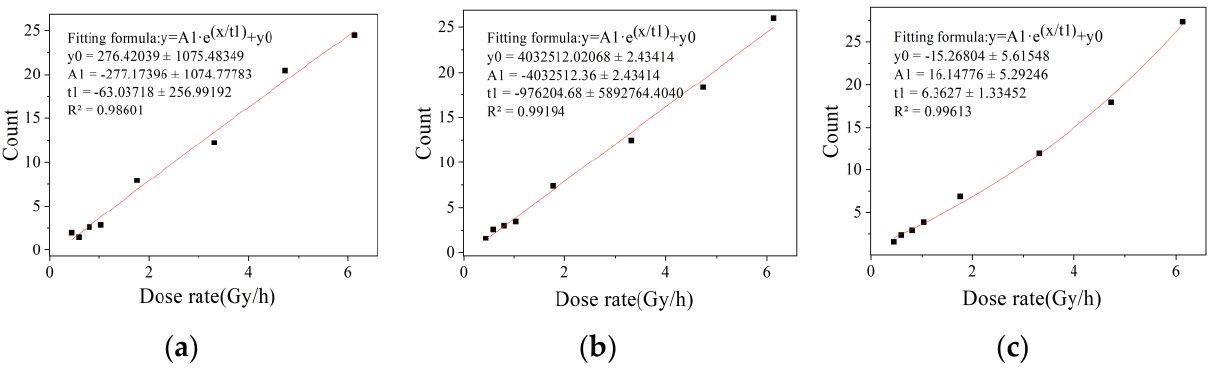
Figure 7. Convergence efficiency of binarized eigenvalue in dark image calibration chamber. ( a ) 100 frame of image data, ( b ) 200 frames of image data and ( c ) 1000 frames of image data.